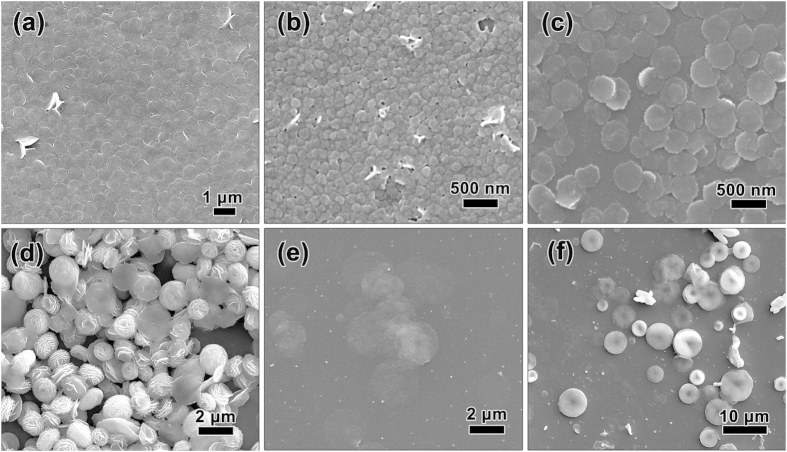
Typical SEM images of SnS2−xSex alloys with different Se concentrations.(a) SnS2; (b) SnS1.66Se0.34; (c) SnS1.22Se0.78; (d) SnS0.82Se1.18; (e) SnS0.44Se1.56; (f) SnSe2.